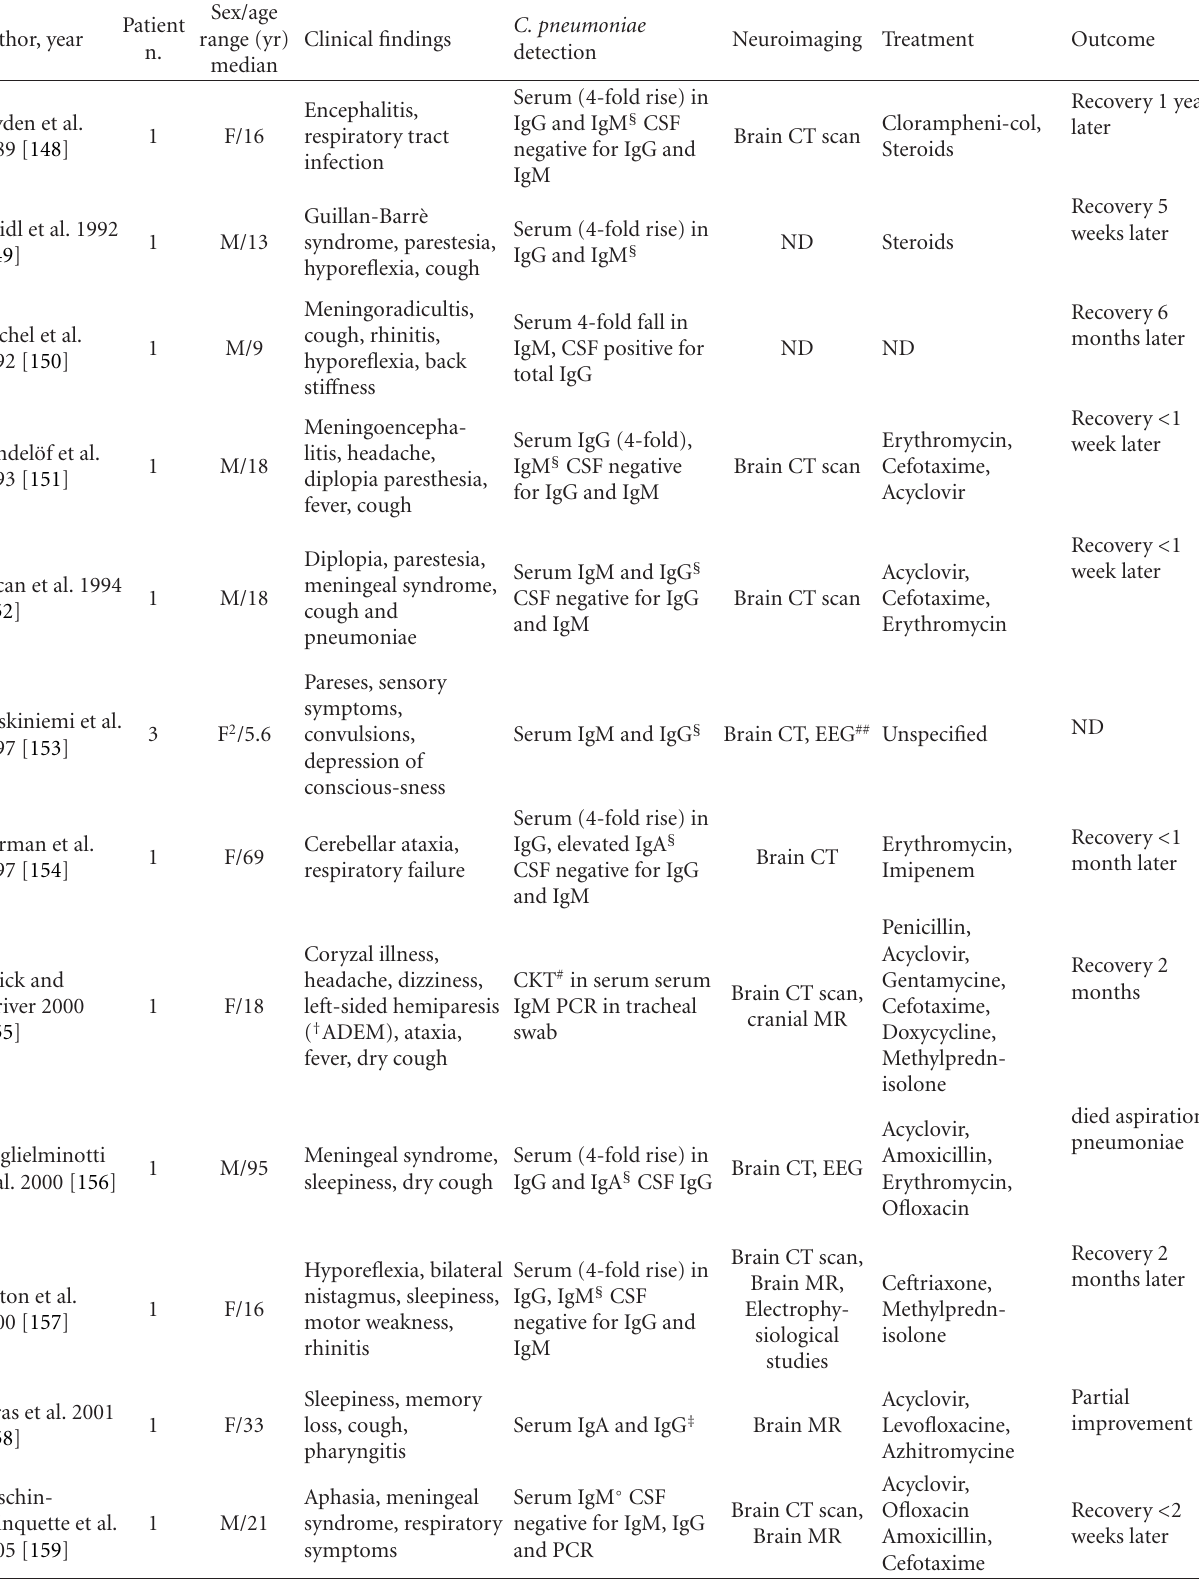
Table 3: Acute and chronic neurological complications preceding or following C. pneumoniae associated respiratory manifestations. Author,